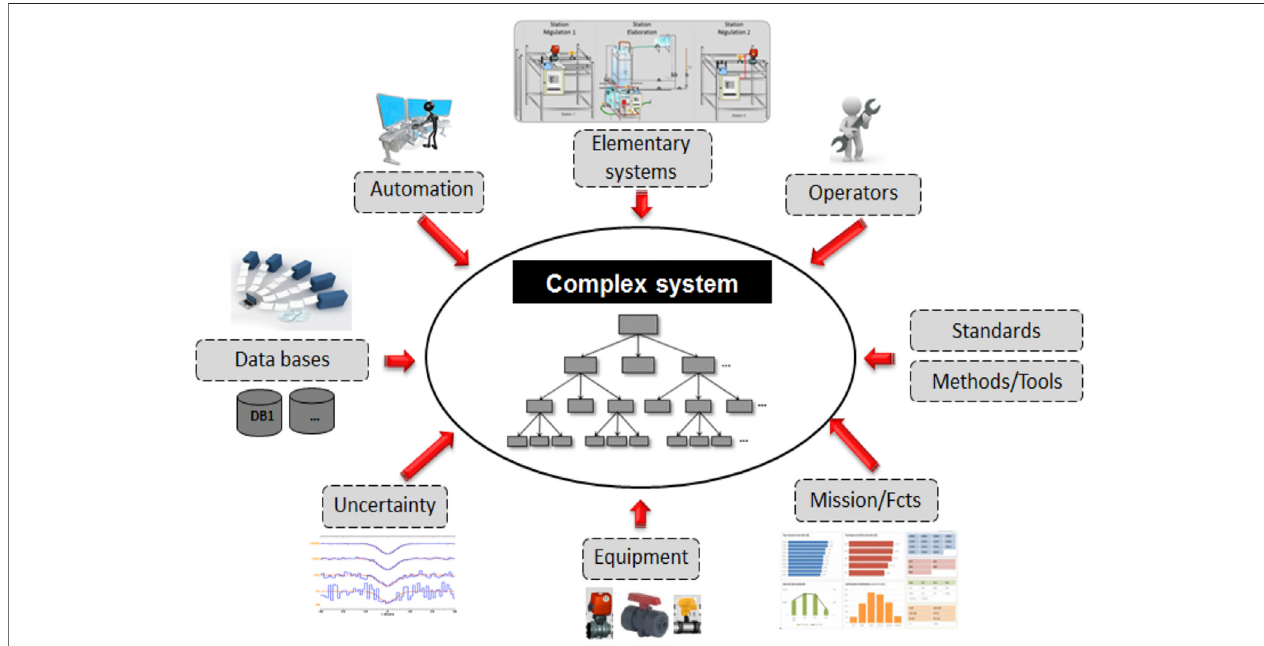
FIGURE 1 | Complex and critical system